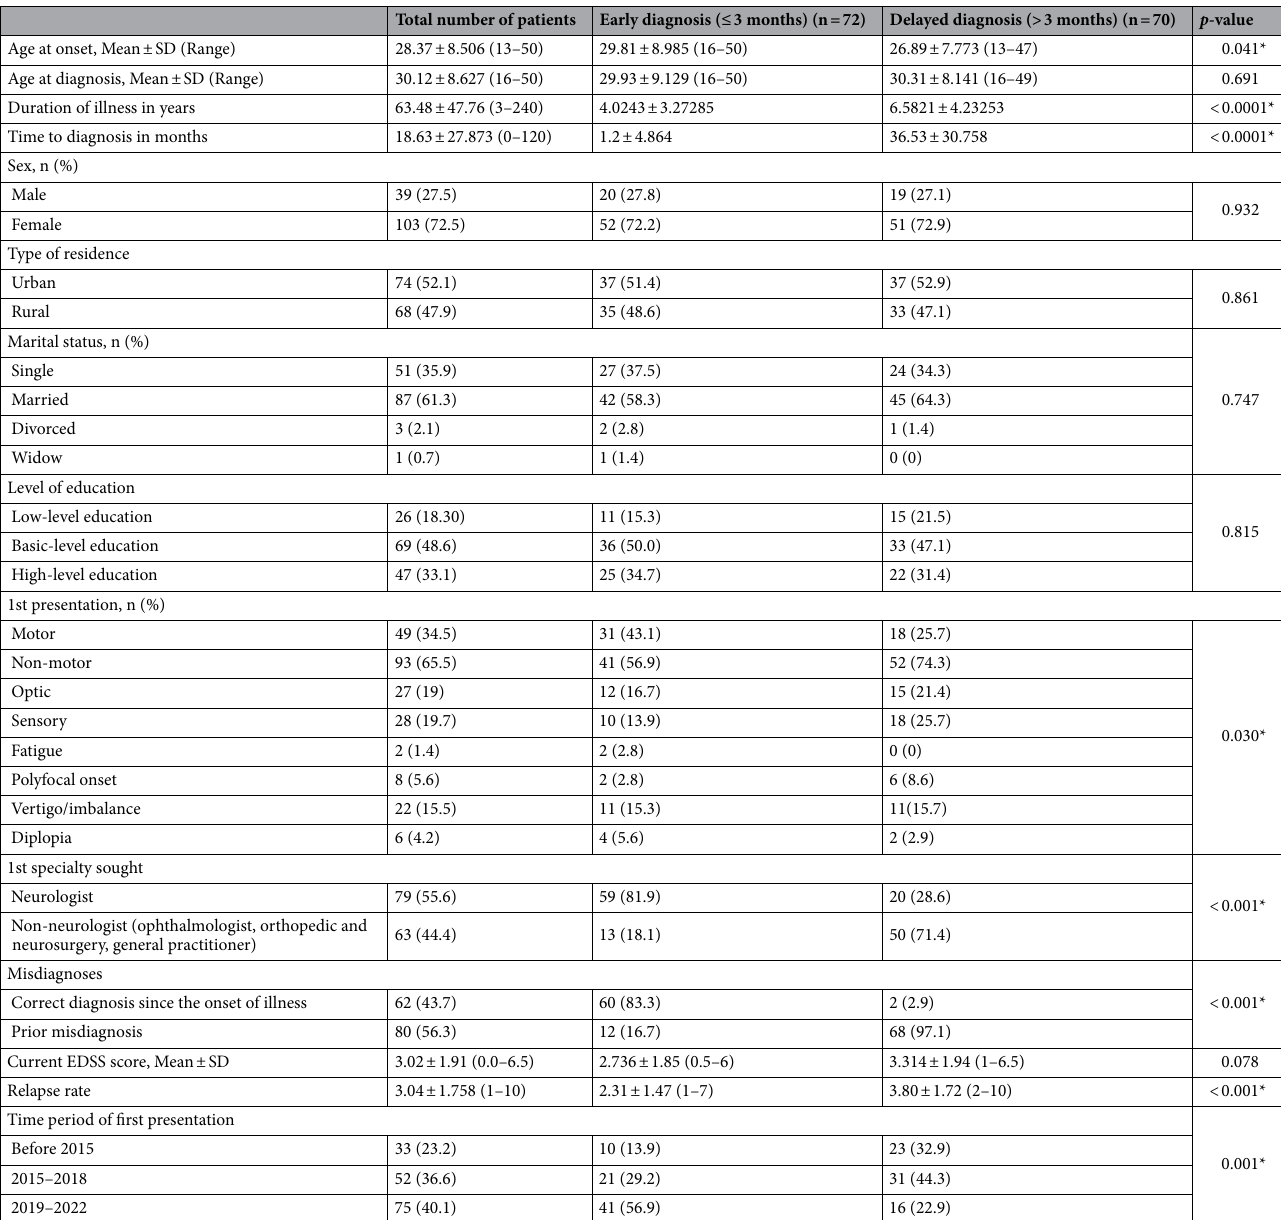
Table 1. Relation between diagnostic delay and different demographic and clinical parameters (n = 142). SD, Standard deviation; p , p -value for comparing between the studied categories. *Statistically significant at p ≤